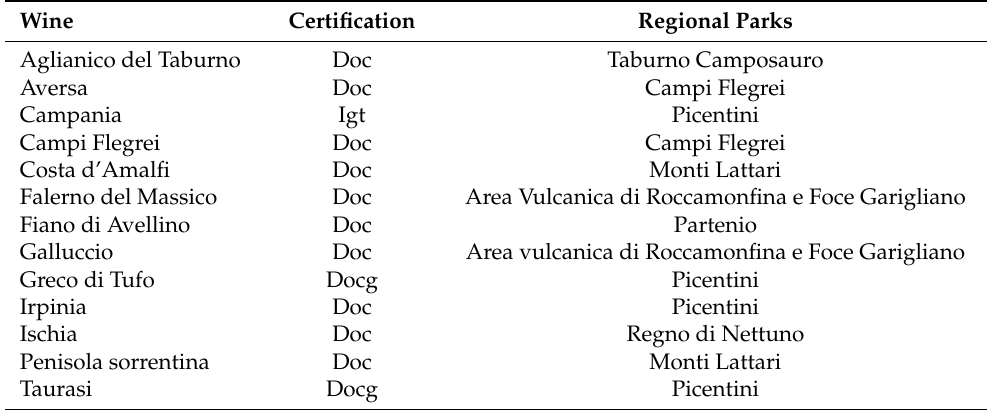
Table 4. Certified wines produced, in part, in regional protected areas in Campania (elaboration Antonio